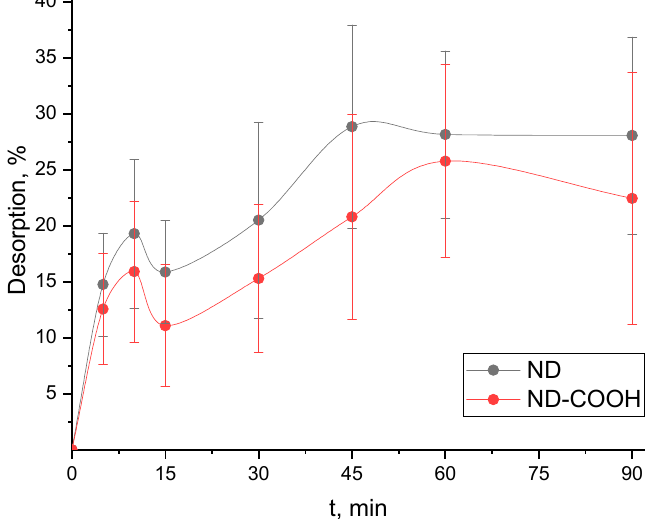
PBS at 37 ◦ Figure 5. Desorption of 68 Ga from ND and ND–COOH (100 μ g/mL) by the solution of 40 g/L BSA in PBS at 37 °C.